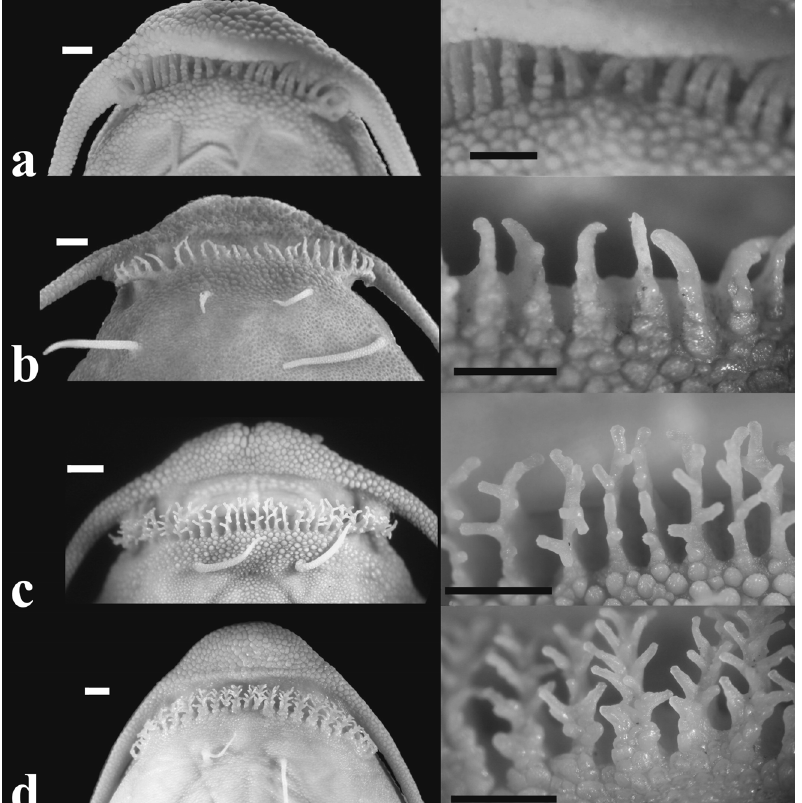
Fig. 2. Ventral view of head and papillae on lower lip of: (a) Xyliphius magdalenae , BMNH 1947.7.1.215.216, 70.0 mm SL; (b) X . anachoretes , MNRJ 31923, holotype, 88.4 mm SL; (c) X . melanopterus , FMNH 99492, 101.5 mm SL; and (d) X . lepturus , FMNH 99489, 108.1 mm SL. Scale bar = 1 mm. Table 1. Morphometric data for Xyliphius anachoretes